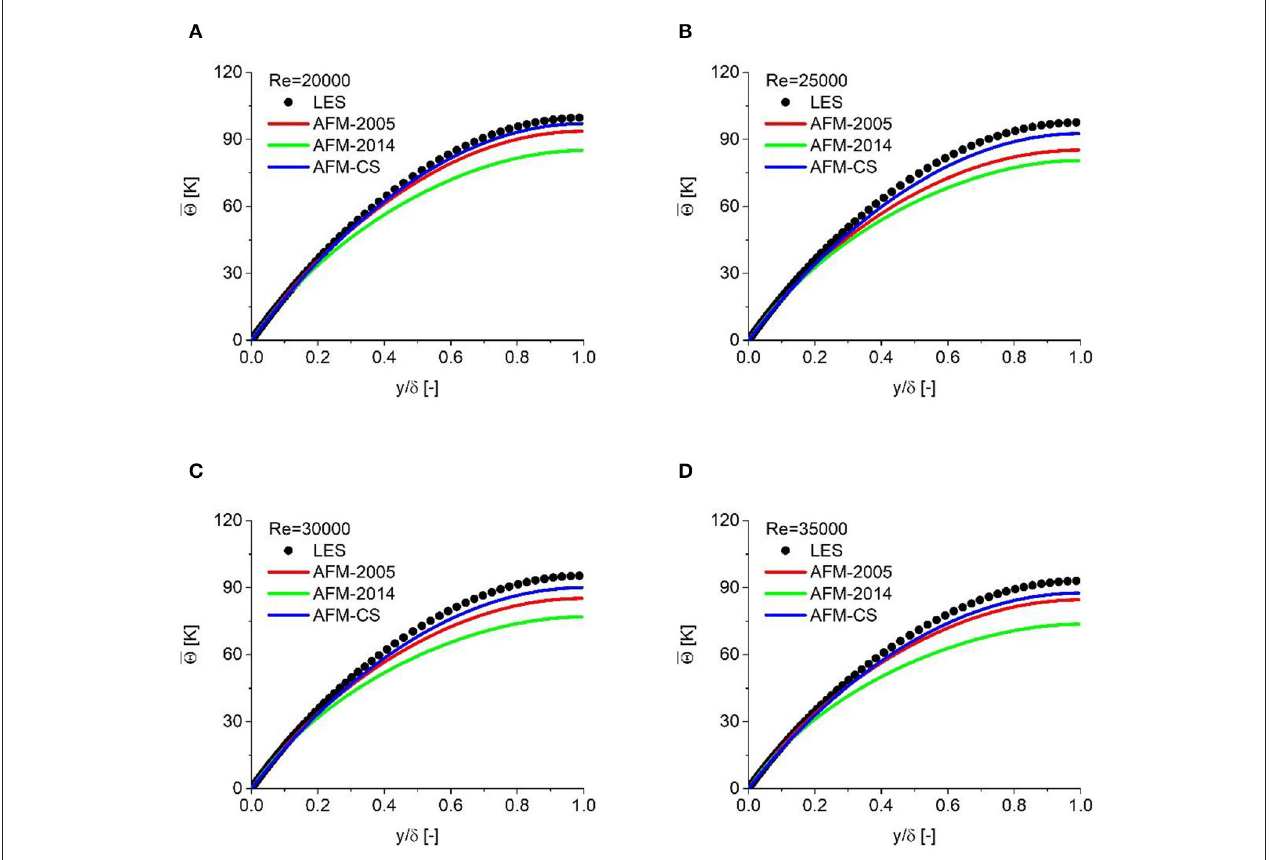
FIGURE 7 | Coolant temperature vs. vertical position for different Reynolds numbers. (A) Re = 20000, (B) Re = 25000, (C) Re = 30000, and (D) Re =